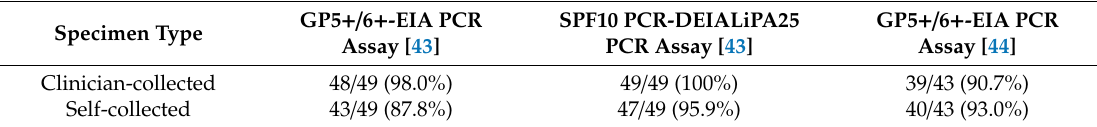
Table1. SensitivityforCIN2 + ofclinician-collectedspecimensandself-collectionusingViba-brushspecimens. Specimen